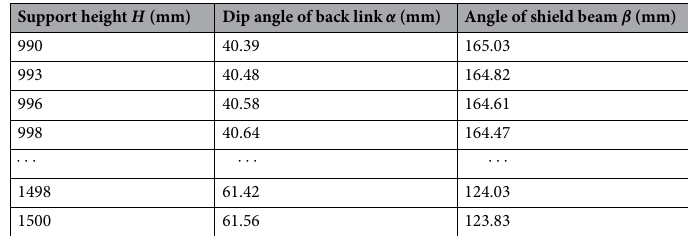
Table 16. Kinematic simulation results of the advanced hydraulic